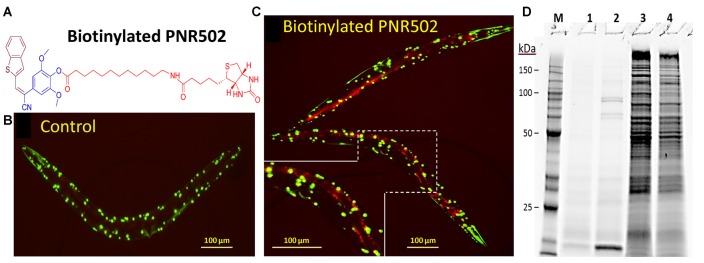
Biotinylated PNR502 localizes to aggregates in AM141 worms and is used to recover drug-adherent proteins. (A) Structure of biotinyl-PNR502. (B,C) AM141 adult worms were either untreated (B) or treated 26 h (C) with 10-μM PNR502 and then fed Alexa594-conjugated streptavidin (Thermo Fisher Scientific, Waltham, MA, USA). Fluorescence images were captured with a Nikon DS-Fi2 camera mounted on a Nikon C2 inverted microscope. Q40::YFP is displayed as green, and Alexa594 as red fluorescence. Yellow fluorescence in (C) indicates the superposition of Q40::YFP with PNR502-Alexa594. (D) Caudal hippocampi, from normal age-matched controls (AMC) or AD patients (pools of three per group), were lysed and incubated 2 h at 4°C with 5-μM PNR502 or biotinyl-PNR502. M, size markers; lanes 1–4, proteins recovered from: 1, unmodified PNR502; 2, biotinyl-PNR502; 3, equivalent portion of flow-through for unmodified PNR502; 4, flow-through from biotinyl-PNR502.